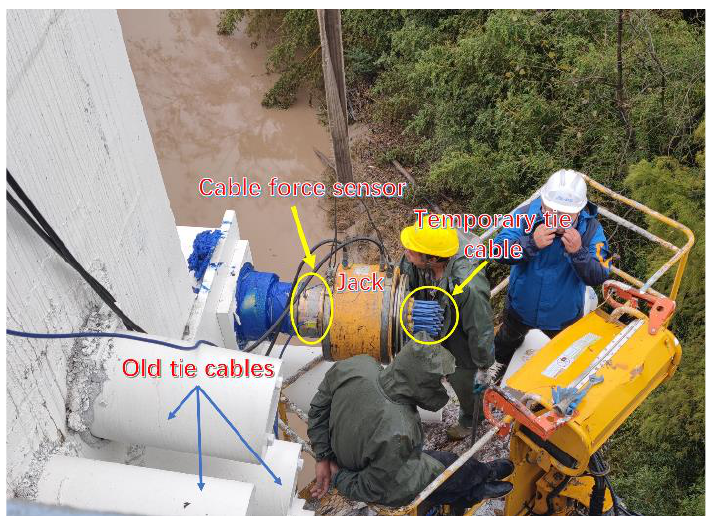
Figure 14. Temporary tie cable tensioning.